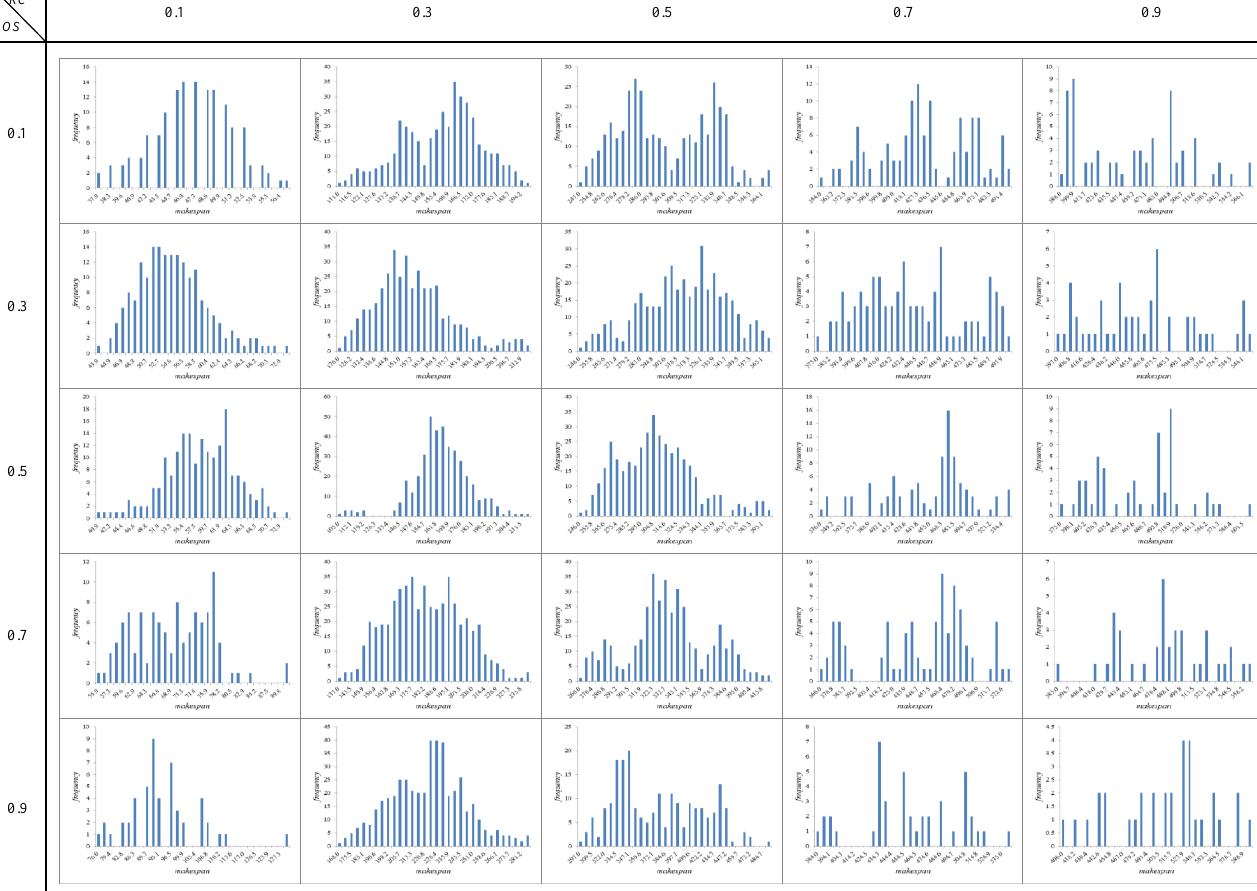
Fig.19 Distribution of makespan under different settings of RC and